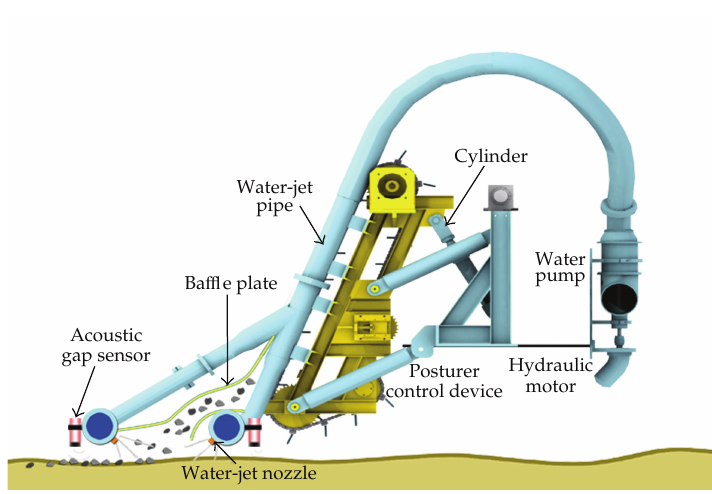
Figure 2: Configuration of hybrid type collector of the deep-ocean test miner.